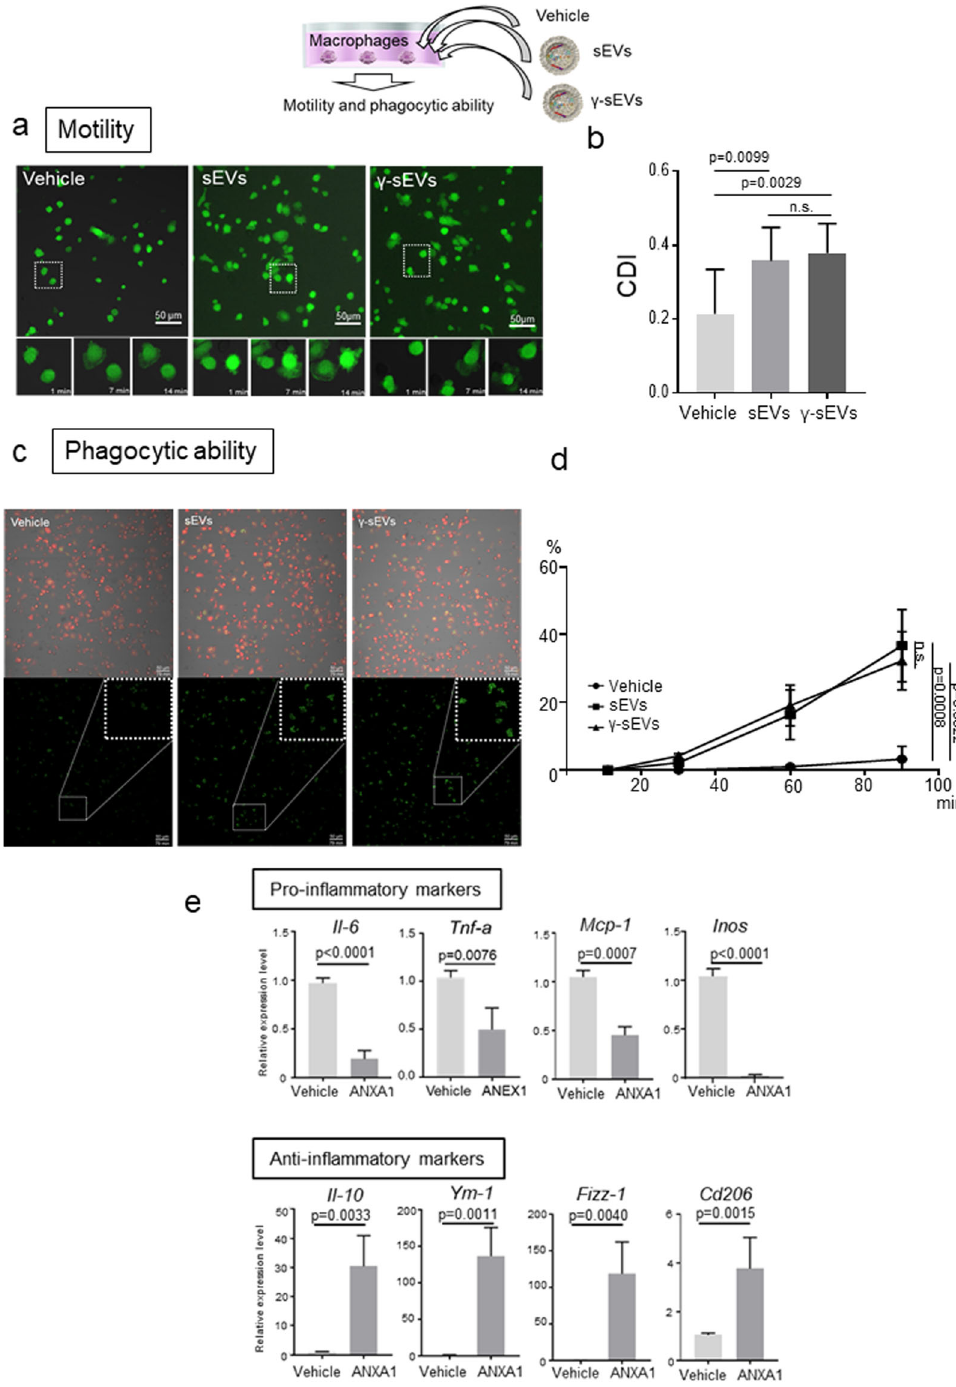
Fig. 2 Macrophage motility and phagocytic ability after addition of AD-MSC-sEVs (sEVs) or AD-MSC- γ -sEVs ( γ -sEVs). a Motility of GFP + macrophages after addition of vehicle, sEVs, and γ -sEVs (Supplementary Movie 1; vehicle, sEVs and γ -sEVs from left to right). b Quanti fi cation of morphological changes in macrophages. Data are presented as means ± SD; ten screens were counted in each experiment. CDI, cell deformation index. c Phagocytic ability of DsRed + macrophages after phagocytosis of pHrodo ™ Green Zymosan Bioparticles ™ conjugate (Supplementary Movie 2; vehicle, sEVs, and γ -sEVs from left to right). d Frequencies of green fl uorescent macrophages observed using time- lapse imaging. Data are presented as means ± SD; ten screens were counted in each experiment 90 min after the addition of sEVs or γ -sEVs. Scale bar = 50 μ m. e Change in macrophage polarity after treatment with recombinant human annexin-A1 + . These macrophage populations were divided into four groups dominantly expressed in macro4, the anti-in fl ammatory macro- phage marker, Cd206 , was expressed in macro1 and macro2, Il-6 (macro1-4) as shown Fig. 4c. Kupffer cell markers, Tim-4 and Clec4f , and Tnf- α were diffusely expressed and Il-10 was mainly expressed were mainly expressed in macro1, the pro-in fl ammatory macro- in macro1 and macro2, and Cx3cr1 was expressed in macro1 and phage marker, Cd80 , was diffusely expressed in all groups but